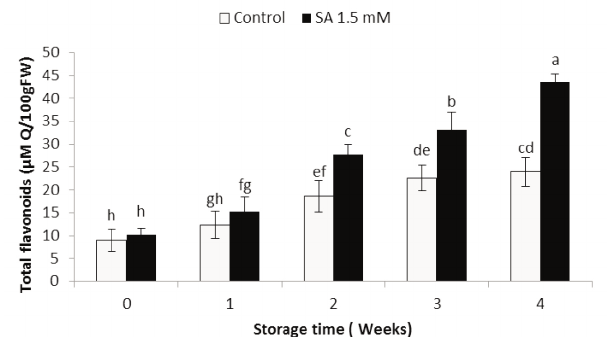
Fig. 4 - Total flavonoids content of peach fruits treated with preharvest SA at 1.5 mM stored at 1±0.5°C for up to 28 days. Data shown are mean ± standard deviation of three replicate (n = 3).